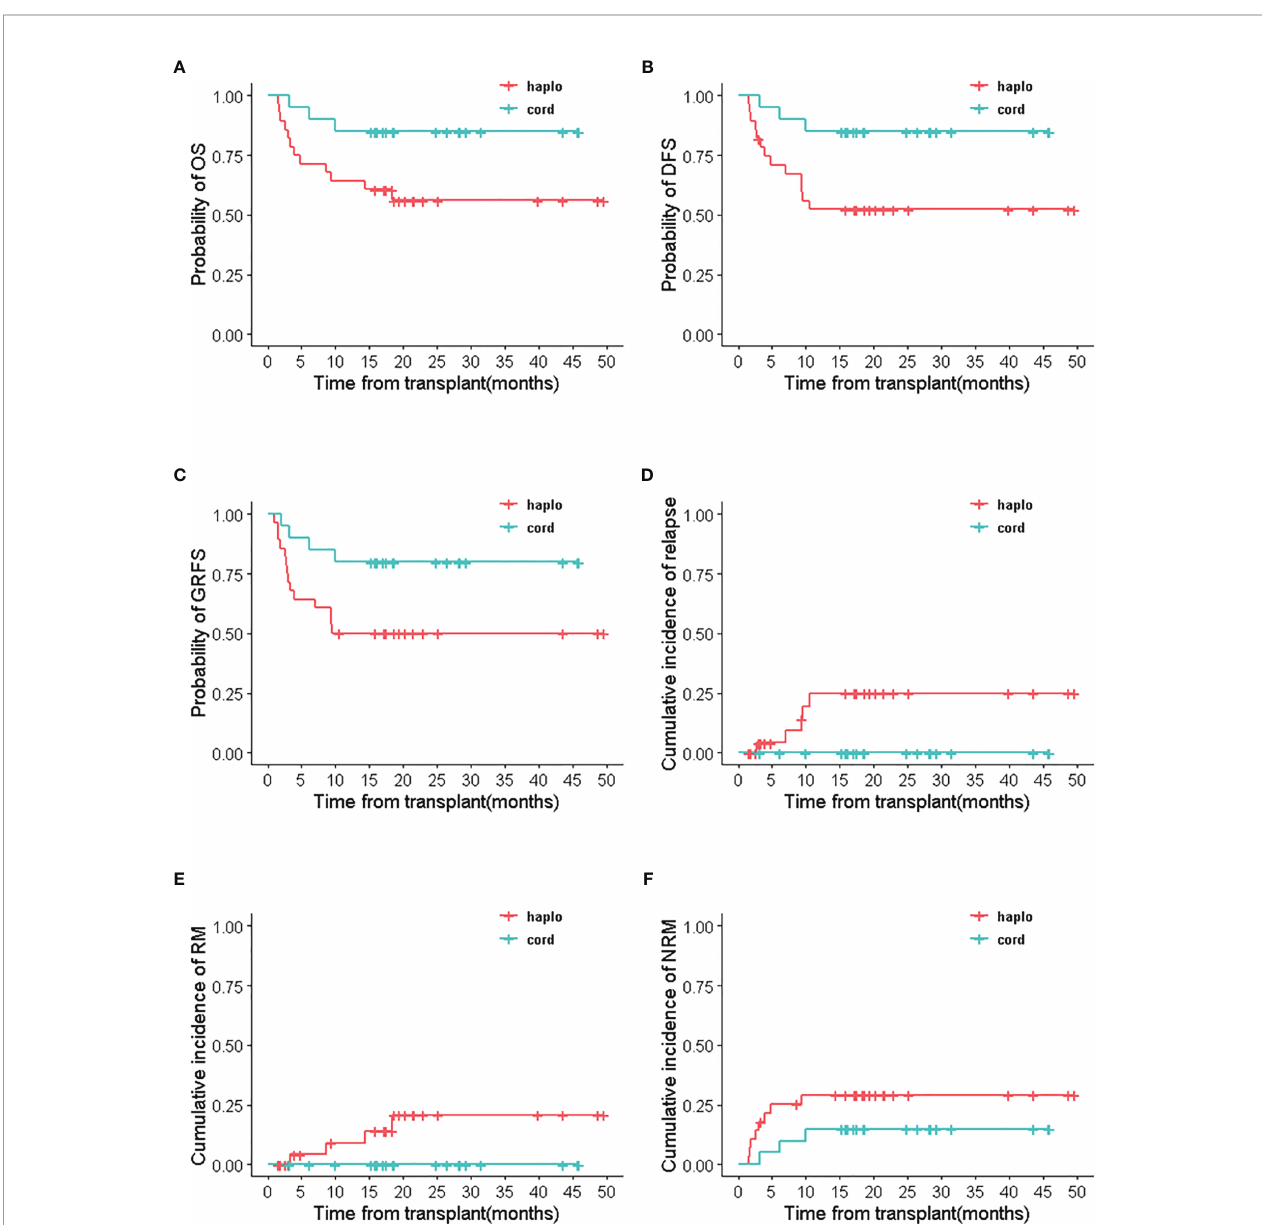
FIGURE 5 | The survival outcomes of haploidentical engraftment and umbilical cord blood engraftment in haplo-cord HSCT group. (A) OS, (B) DFS, (C) GRFS, (D) RI, (E) RM, (F) NRM.